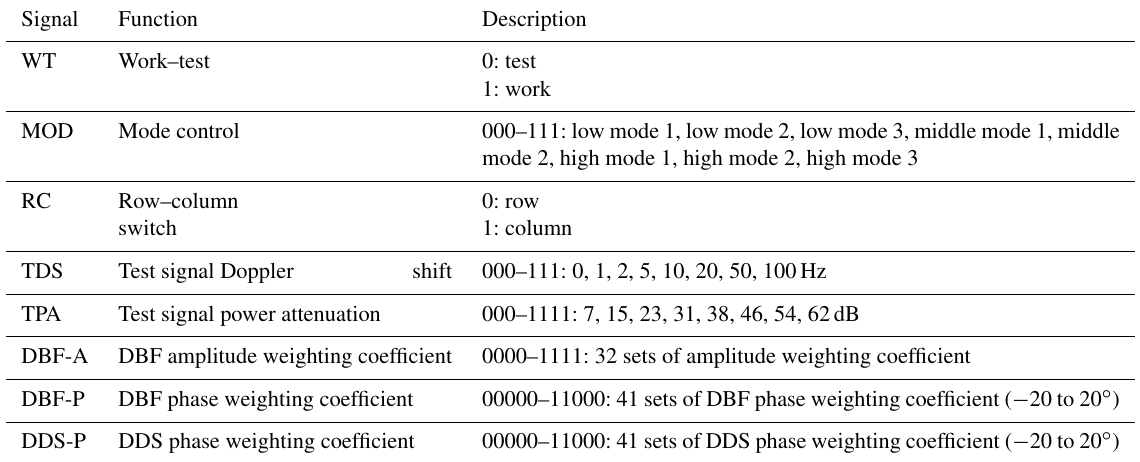
Table 2. Description of control